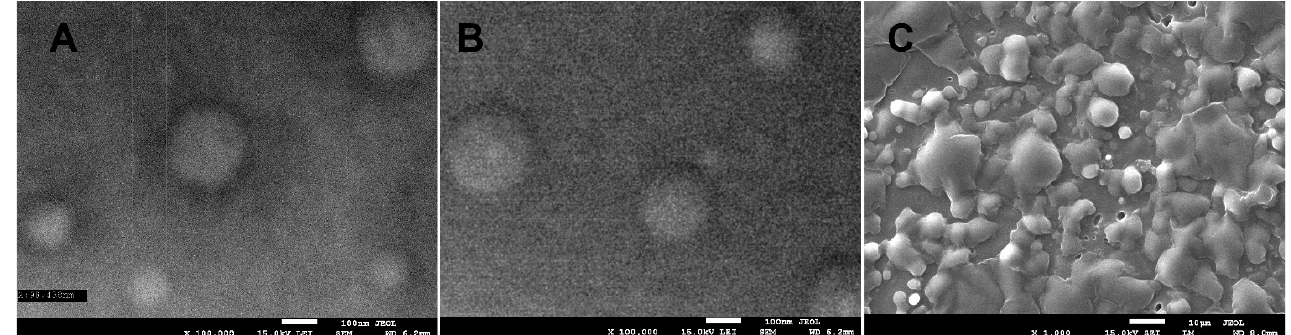
Figure 1. SEM images of a hyaluronic bionanocomposite containing nanocapsules with propolis: ( A )—HP1 at 100,000× magnification; ( B )—HP2 at 100,000× magnification; ( C )—HP3 at 1000 × magnification.